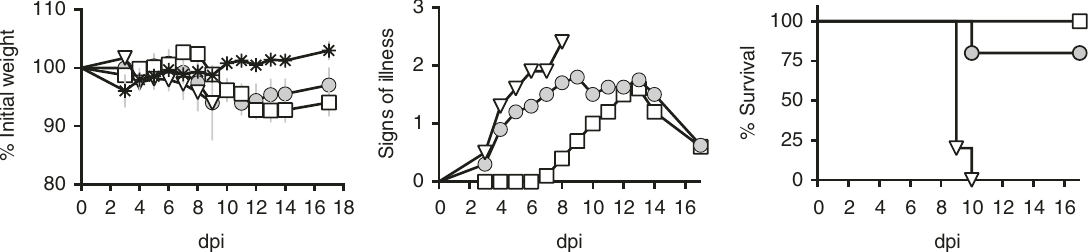
IFN α / β BP GAGmut expressing viruses resulted in a dramatic attenuation phenotype compared to WT virus infections. The IFN-I activation in mice infected with the IFN α / β BP GAGmut expressing viruses is expected to enhance T (CD8 + , CD4 + ) and NK cell responses, as shown in mice infected with an ECTV IFN α / β BP mutant 23 . The interaction of the IFN α / β BP with GAGs may interfere with attachment of chemokines to the cell surface, as proposed for some viral CKBPs 39 . Although the IFN α / β BP will mask a reduced number of GAG-binding sites at the cell surface, we cannot rule out the possibility that the binding of IFN α / β BP to GAGs may have some indirect effect on chemokine-mediated leucocyte migration to sites of infection. Virus dissemination is signi fi cantly impaired after infection in the absence of a fully functional viral IFN α / β BP. Viral loads in major target organs from animals infected with the IFN α / β BP deletion mutant virus dropped to undetectable levels between 5 and 7 dpi, suggesting a role for the IFN system in virus clearance that would support the lack of evident mousepox disease. In the case of the sole abrogation of the viral IFN α / β BP cell attachment proper- ties, the viral loads in spleen and liver, although clearly reduced compared to WT infection, still remained detectable at 7 dpi indicating a loss of viral IFN α / β BP effectiveness to prevent the IFN effects. This level of viral replication, coincident with limited liver damage and enlarged spleens, may account for the signs of illness observed in mice infected with the IFN α / β BP GAGmut expressing